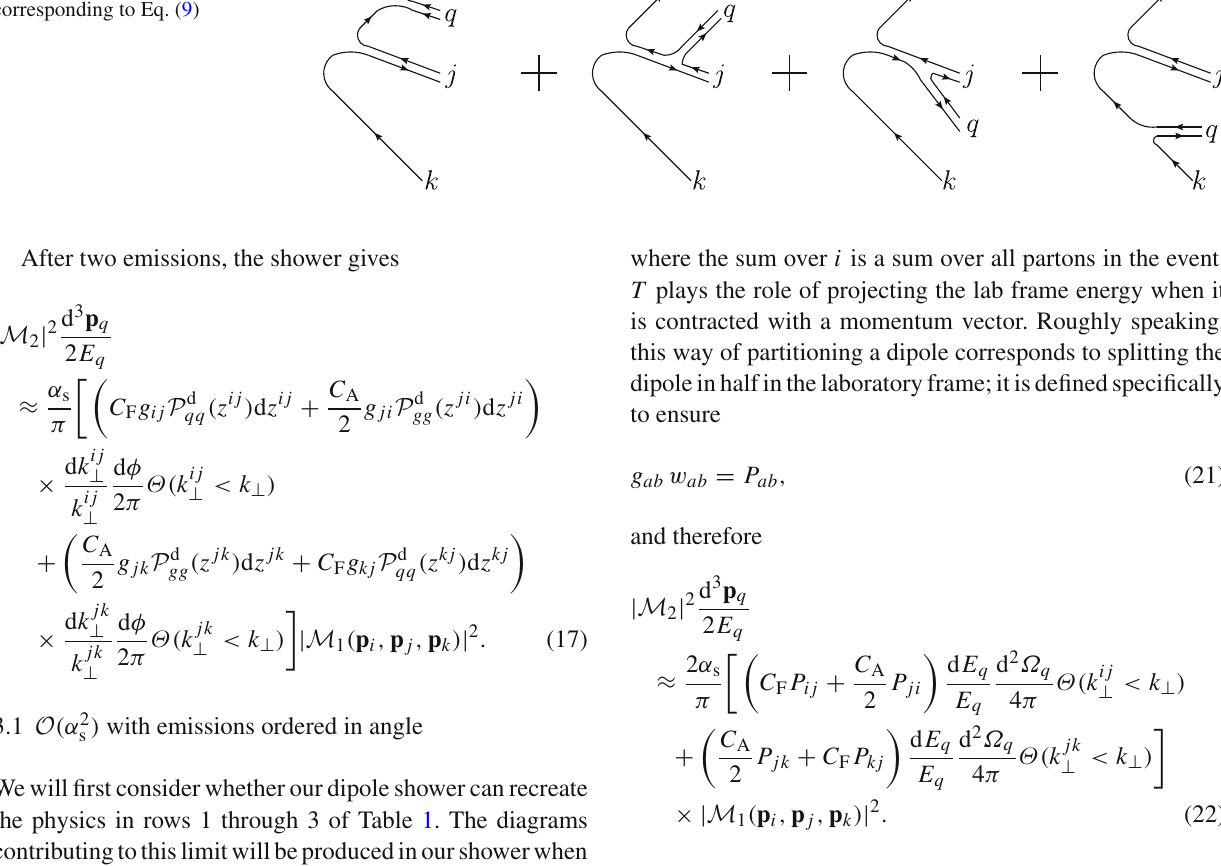
Fig. 3 The relevant colour topologies in a dipole shower corresponding to Eq.